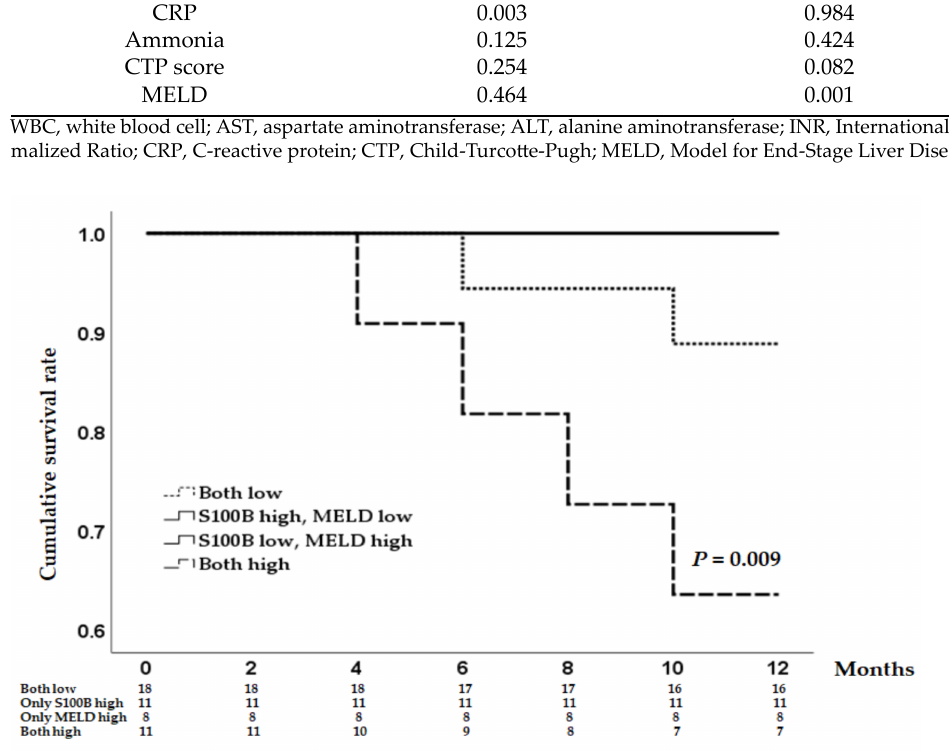
Figure 4. Kaplan–Meier curve displaying the estimated survival probability for the four different groups of patients without any types of hepatic